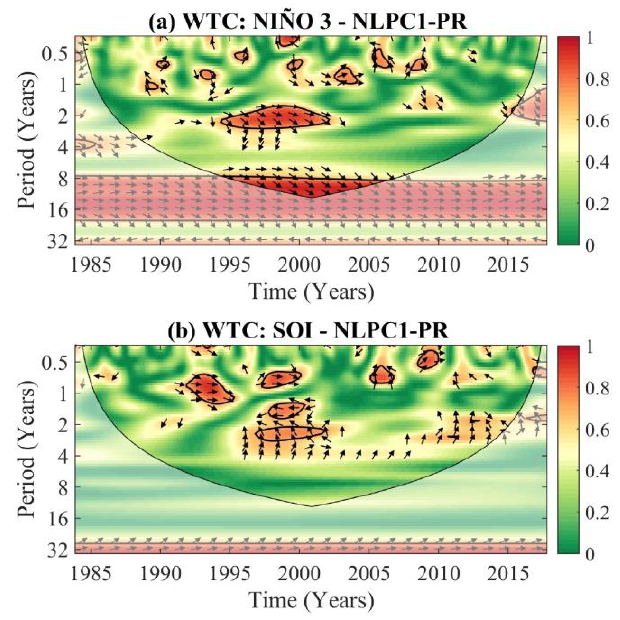
Figure 11. Wavelet transforms coherence between the NLPC1-PR series and climate-oceanographic indices: ( a ) SST3 and ( b ) SOI. The closed contours indicate the squared Wavelet Coherence. The region where the edge e ff ects are significant is under the cone of influence. The arrows denote phase di ff erences: in-phase (0 ◦ ), arrows point out to the right; out of phase (180 ◦ ), arrows point out to the left; the first-time series leads the second by 90 ◦ , pointing down; and, the first-time series, the second one by 90, pointing upwards.